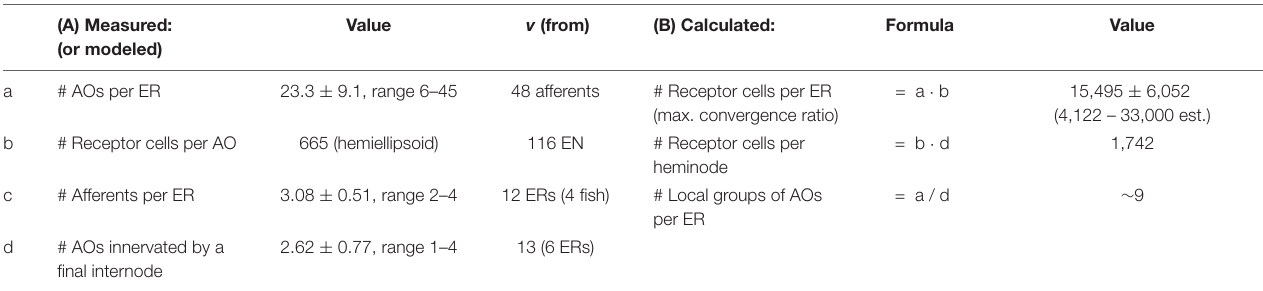
TABLE 4 | Summary of convergence